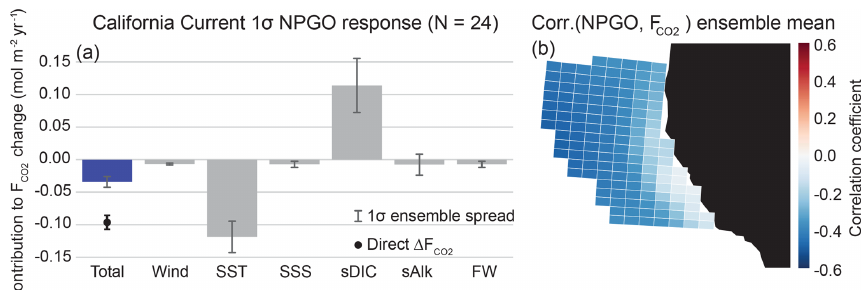
Figure 6. Linear Taylor expansion from Eq. (4) for CalCS CO 2 flux anomalies regressed on the NPGO (a) . Gray bars represent the ensemble mean contributions of each variable to the CO 2 flux anomaly. Error bars represent the 1-standard-deviation spread of the full ensemble. The on the NPGO, which is denoted as the black dot with its individual bars sum to the “total” bar to approximate the direct regression of (cid:49)F CO 2 associated ensemble spread. The ensemble mean grid cell correlations between CO 2 flux anomalies and the NPGO in the CalCS study region are displayed in (b) . Positive correlations are associated with outgassing; negative correlations are associated with uptake. The magnitude and ensemble spread for each bar is presented in Table 2.